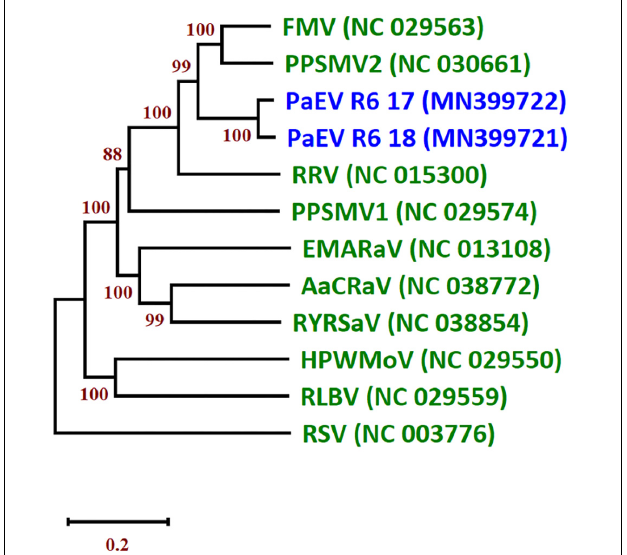
FIGURE 4 | Neighbor joining tree (NJ) of the nucleocapsid protein (NP) of the two isolates of pea associated emaravirus (PaEV) detected in Germany and representative emaraviruses. The phylogenetic trees are based on alignments of the amino acid sequences. The sequences were aligned with Clustal W and NJ trees constructed with MEGA X. The percentage of the bootstrap values above 50% (1,000 replications) are shown at the nodes. Virus acronyms and names are as follows: AcCRaV, Actinidia chlorotic ringspot-associated emaravirus; EMARaV, European mountain ash ringspot-associated emaravirus; FMV, fig mosaic emaravirus; HPWMEV, high plains wheat mosaic emaravirus; PaEV, pea associated emaravirus; PPSMV1, pigeonpea sterility mosaic emaravirus 1; PPSMV2, pigeonpea sterility mosaic emaravirus 2; RLBV, raspberry leaf blotch emaravirus; RRV, rose rosette emaravirus; RSV, rice stripe virus ( Tenuivirus; Phenuiviridae ) and RYRSaV, redbud yellow ringspot-associated emaravirus. The GenBank accession numbers are in brackets. The scale bar indicates the genetic